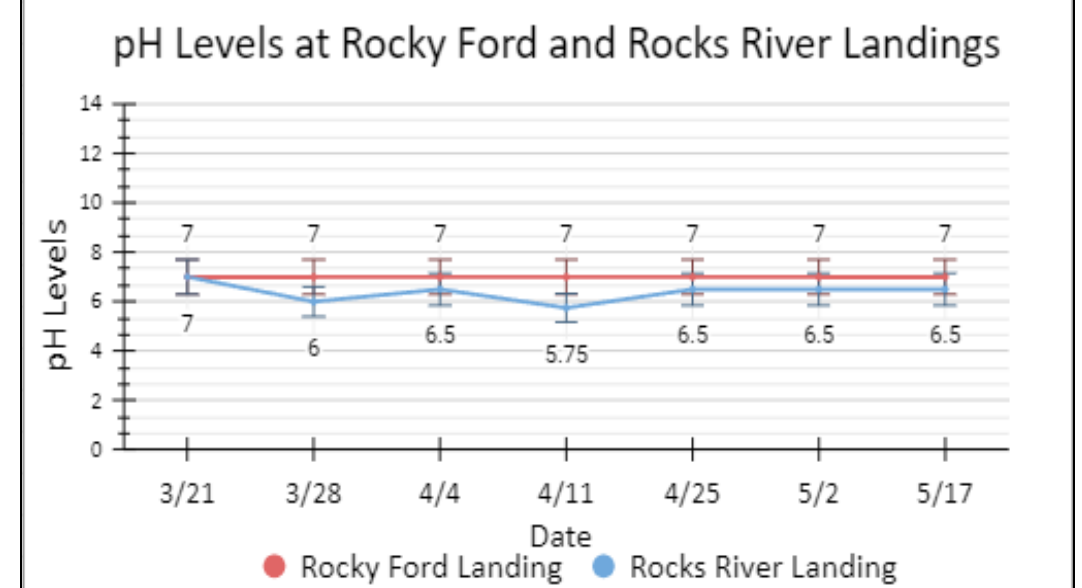
Figure 8. Water Quality — Water Temperature in Degree Celsius from March – May 2022.